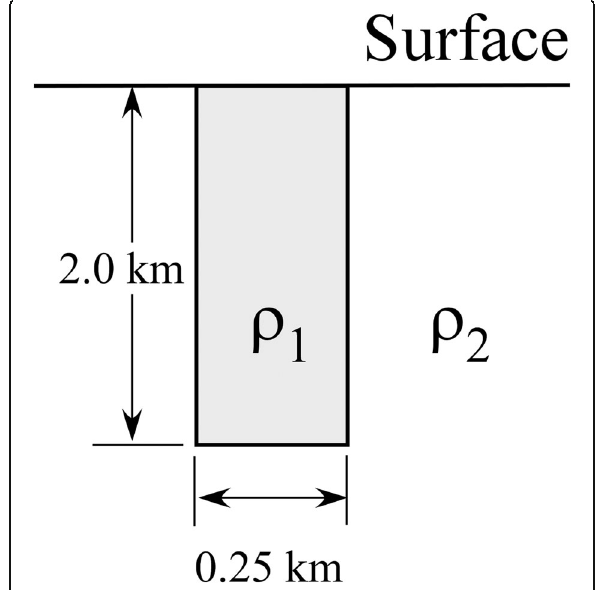
Fig. 3 Model of subsurface structures. Here, rectangular causative body of width and height of 0.25 and 2.0 km, respectively, is assumed. Densities of a medium and a causative body are ρ 2 and ρ 1 , respectively